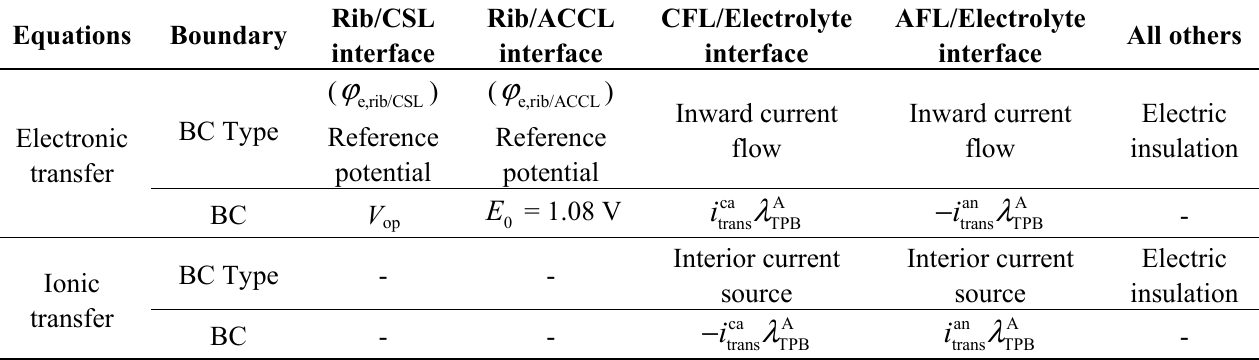
Table 2. Boundary settings for the electronic and ionic charge transfer equations. “Electric Insulation” makes the normal component of the electric current